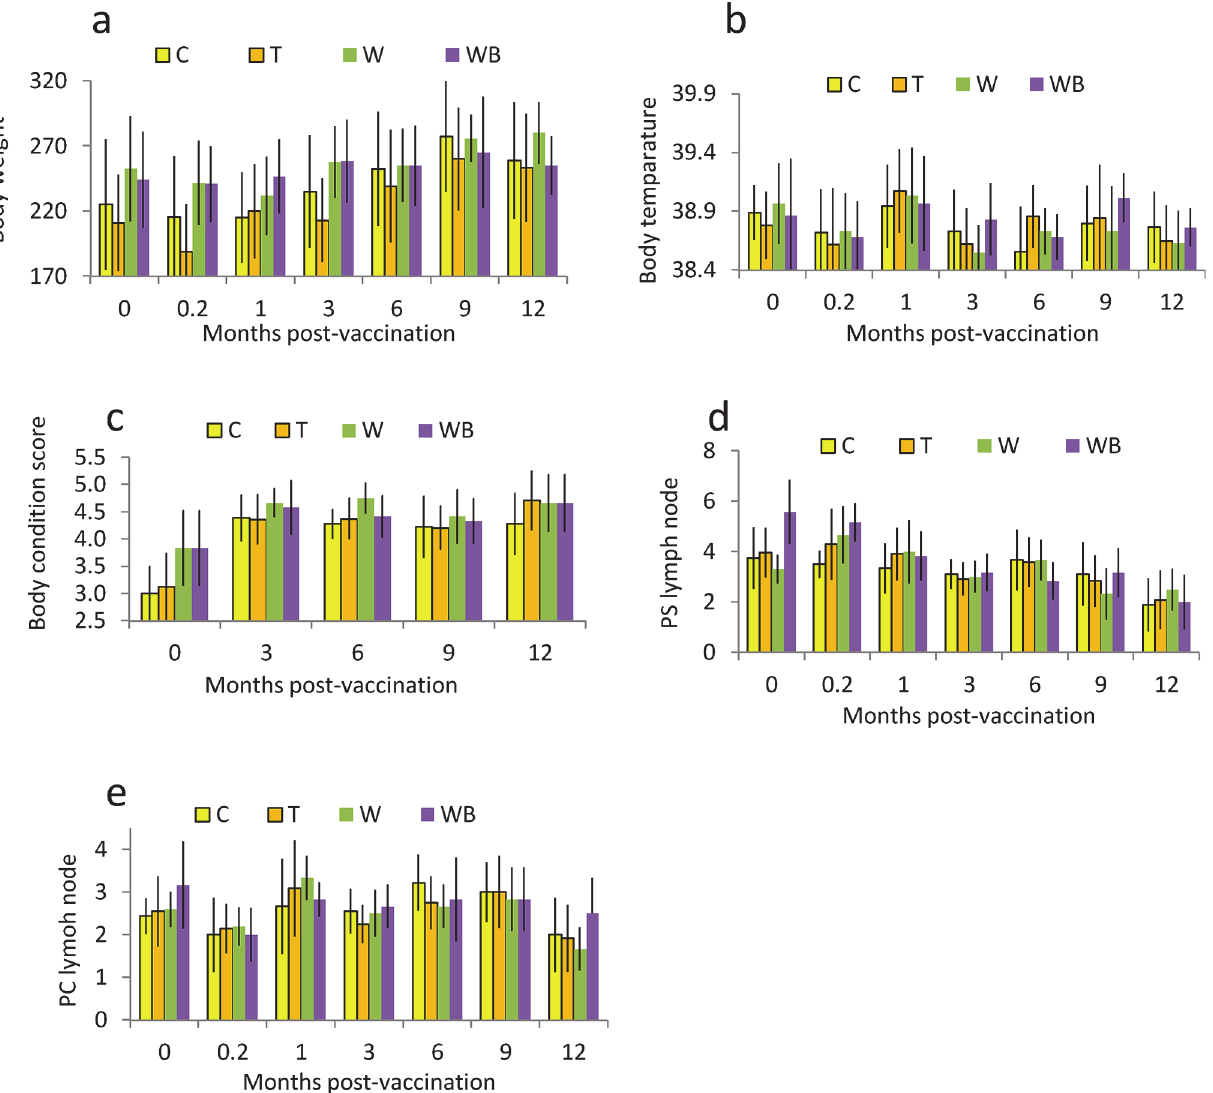
Fig 2. Mean (SD) body weight (a), body temperature (b), body condition score (c) and diameter of pre-scapular (d) and pre-crural (e) lymph nodes in Control (C), Treated (T), Webbed (W) and Webbed-boosted (WB) cattle. T, W and WB were treated with a single dose of the immunocontraceptive GonaCon, WB received a booster dose three months later. W and WB had their oviducts removed before the